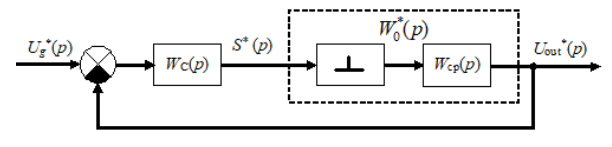
Figure 3. The block diagram of the synthesized pulse